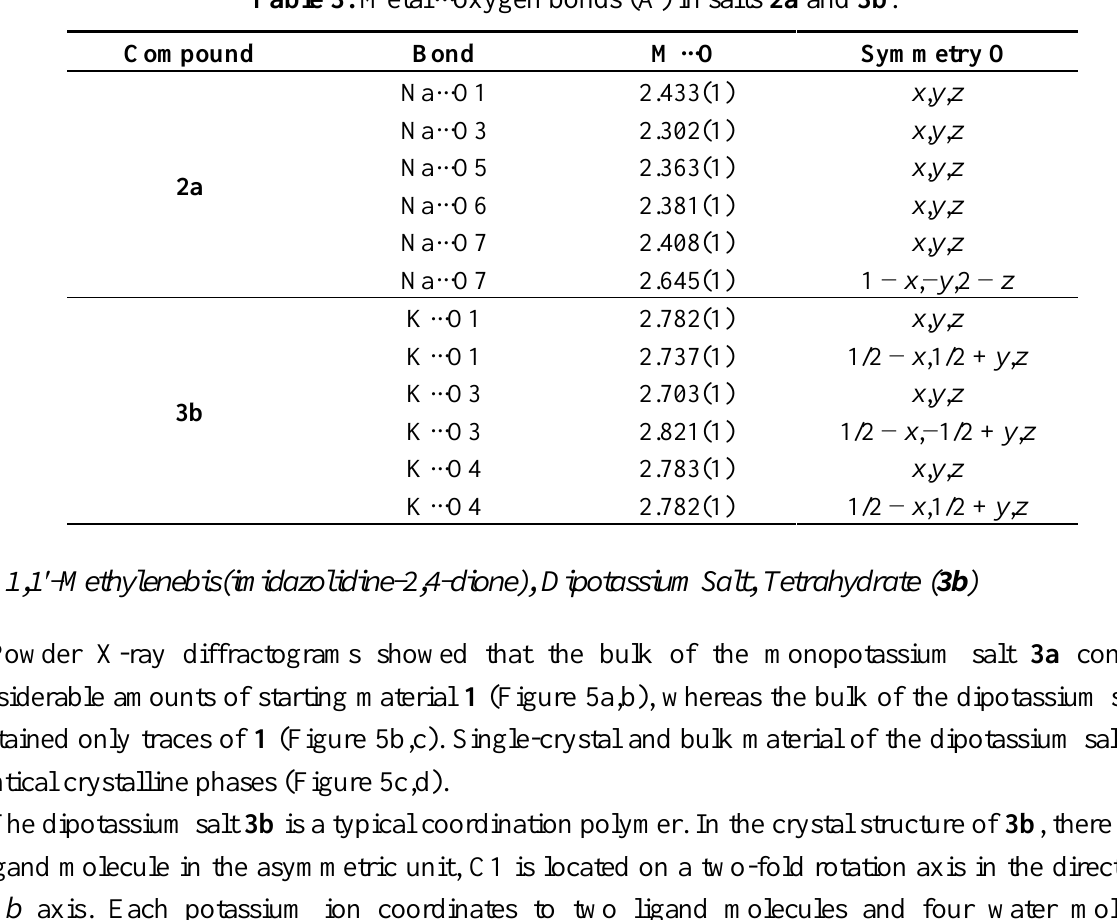
Table 3. Metal...oxygen bonds (Å) in salts 2a and 3b